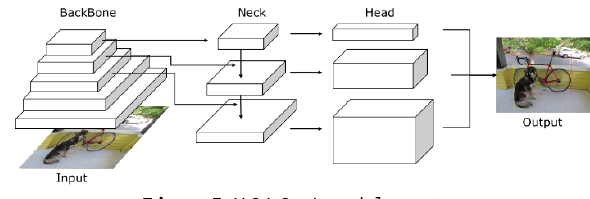
Figure 5 . YOLOv4 model